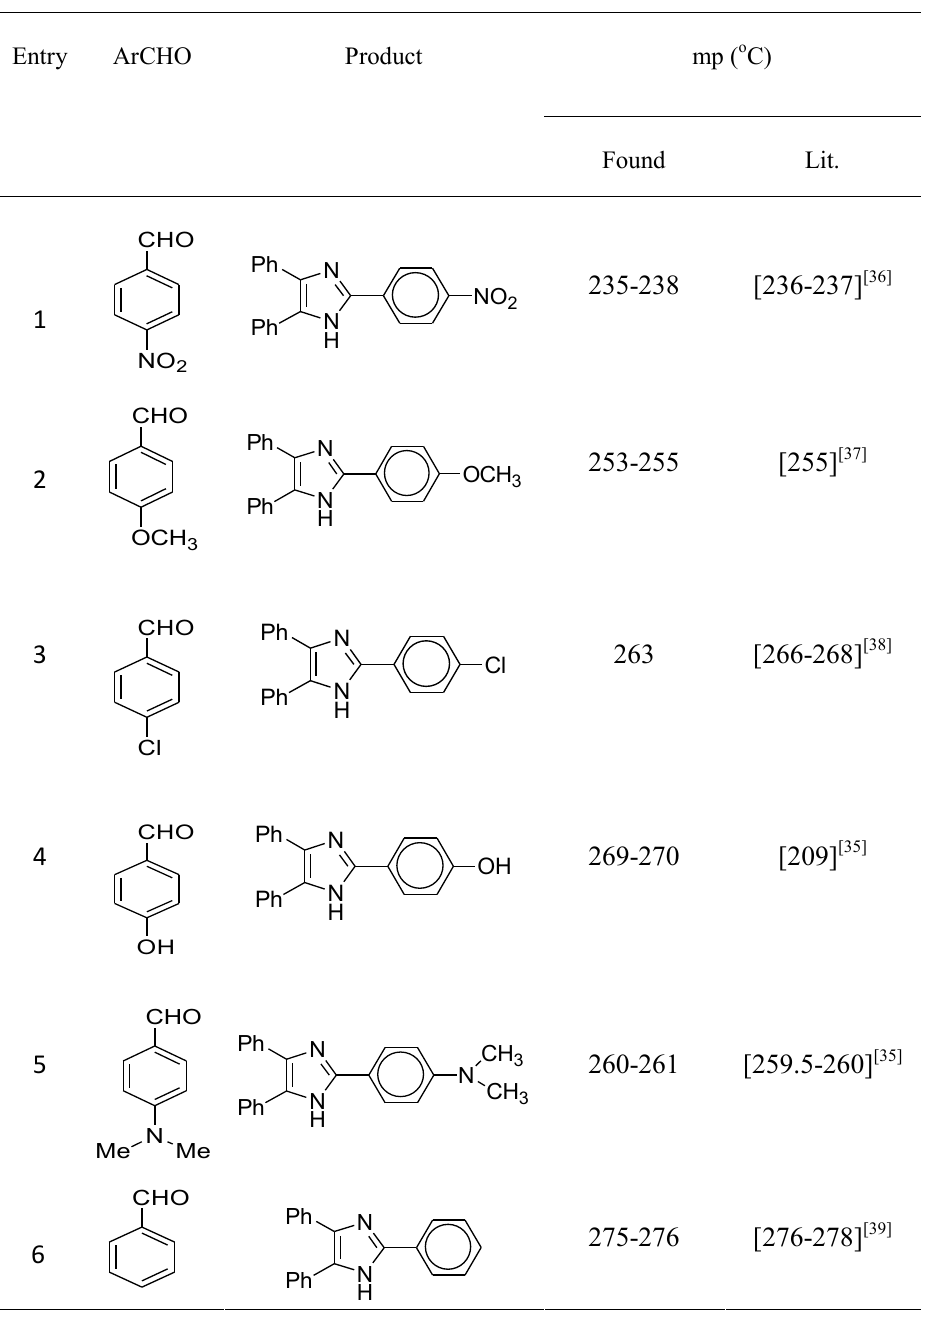
The synthesis of trisubstituted imidazoles using Benzyl, Ammonium acetate and substituted